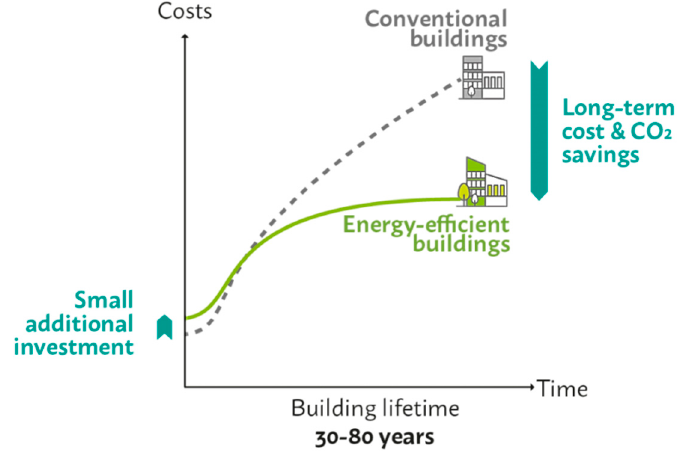
Figure 12. The future strategy of sustainable building construction as a response to the post-COVID-19 crisis (Adapted from [116]).